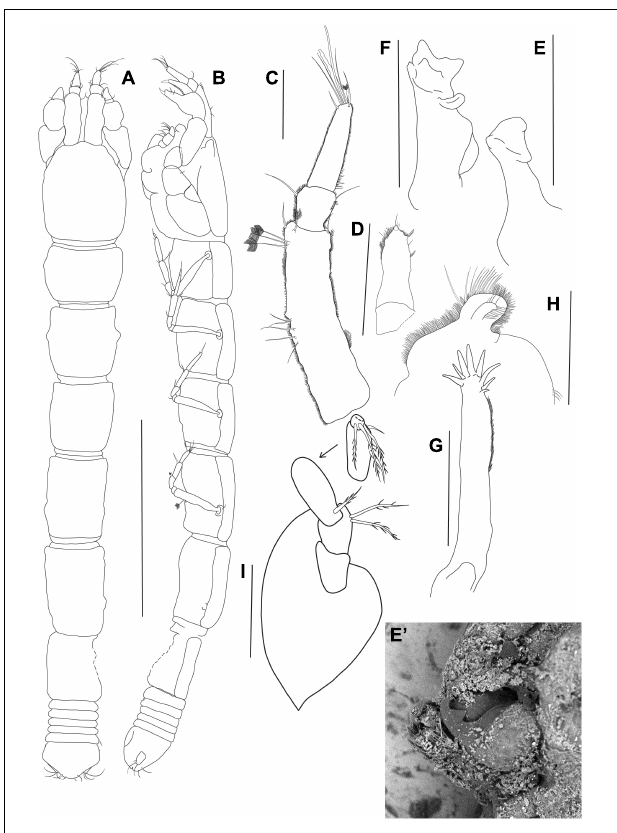
FIGURE 3 | Agathotanais beatae n. sp., neuter, holotype ( A,B : ZMH-K-61146; C–I ZMH-K-61147). (A) dorsal view; (B) lateral view; (C) antennule; (D) antenna; (E) right mandible; (E’) details of right mandible (SEM image); (F) left mandible; (G) maxillule; (H) labrum; (I) maxilliped. Scale bars: (A,B) = 1 mm, (C–I) = 10 µ m.